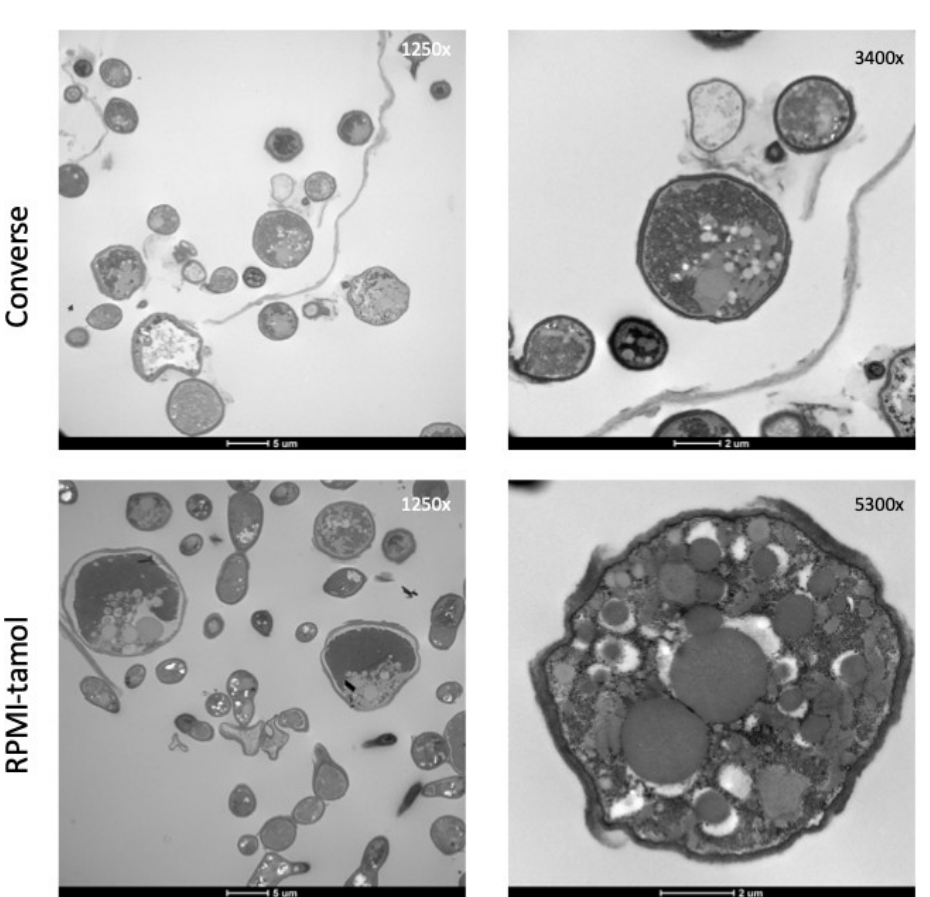
Figure 5. TEM images of C. posadasii S/E strain following 168 h growth in RPMI-tamol or Converse media. The shape of spherules grown in RPMI-tamol media are highly irregular compared to spherules grown in Converse media.